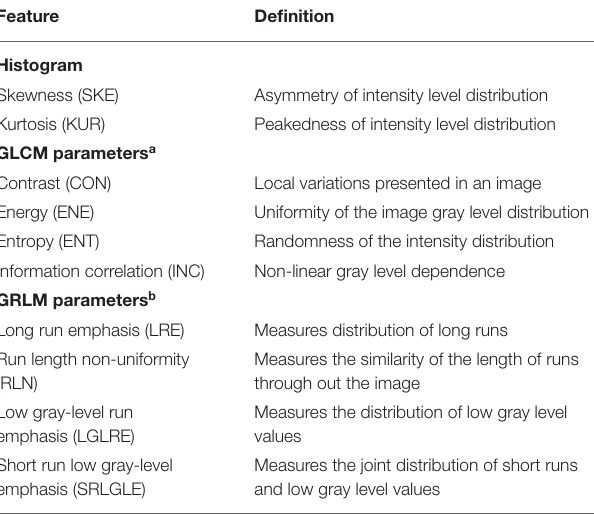
TABLE 1 | Definitions of extracted features.